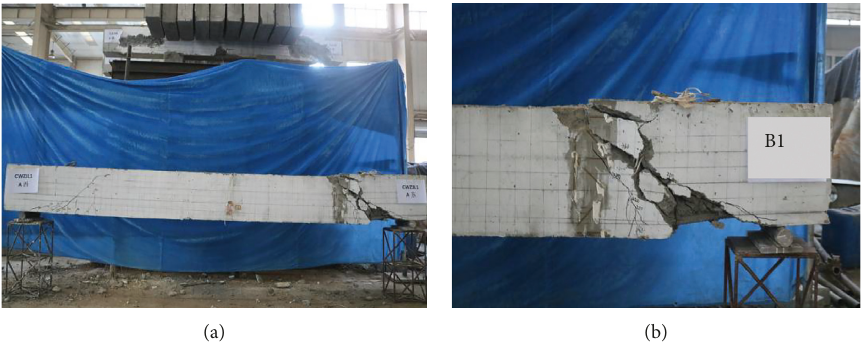
Figure 4: The failure modes of B1. (a) Overall failure mode; (b) partial failure mode.